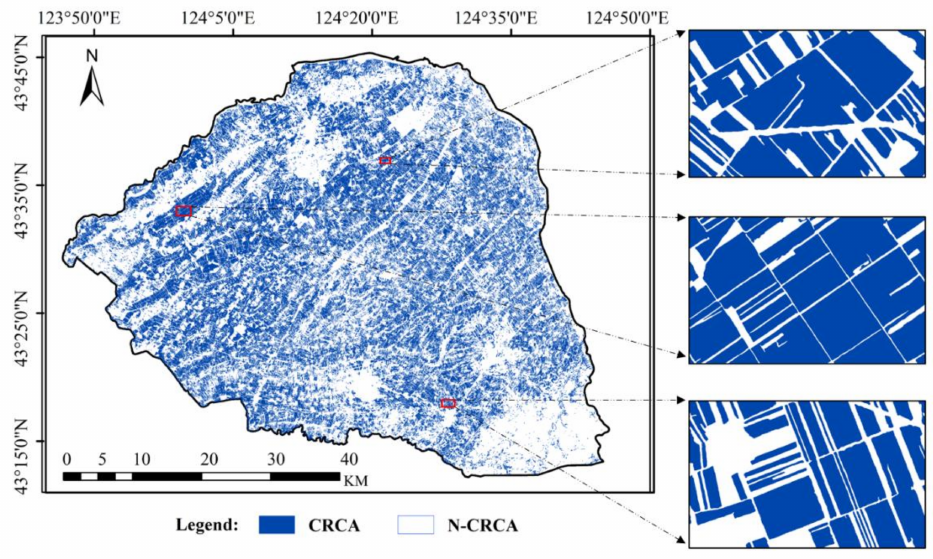
Figure 9. The classification result of corn residue covered area using MSCU-net + C in Lishu